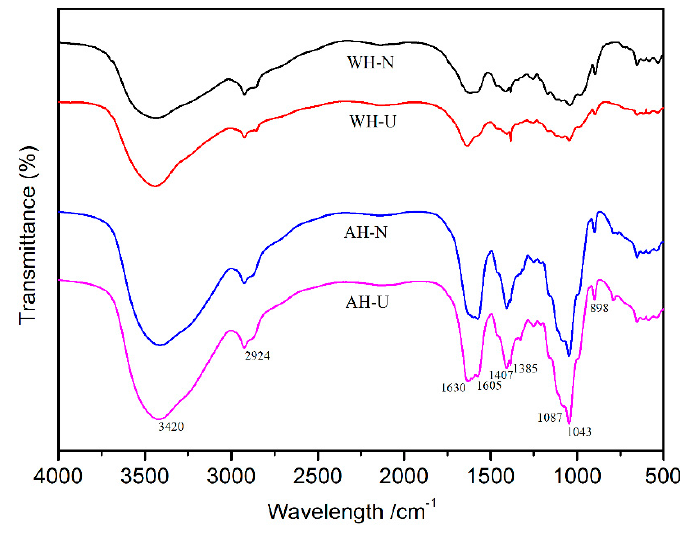
Figure 3. FT-IR spectra of WH-N, WH-U, AH-N, and AH-U.